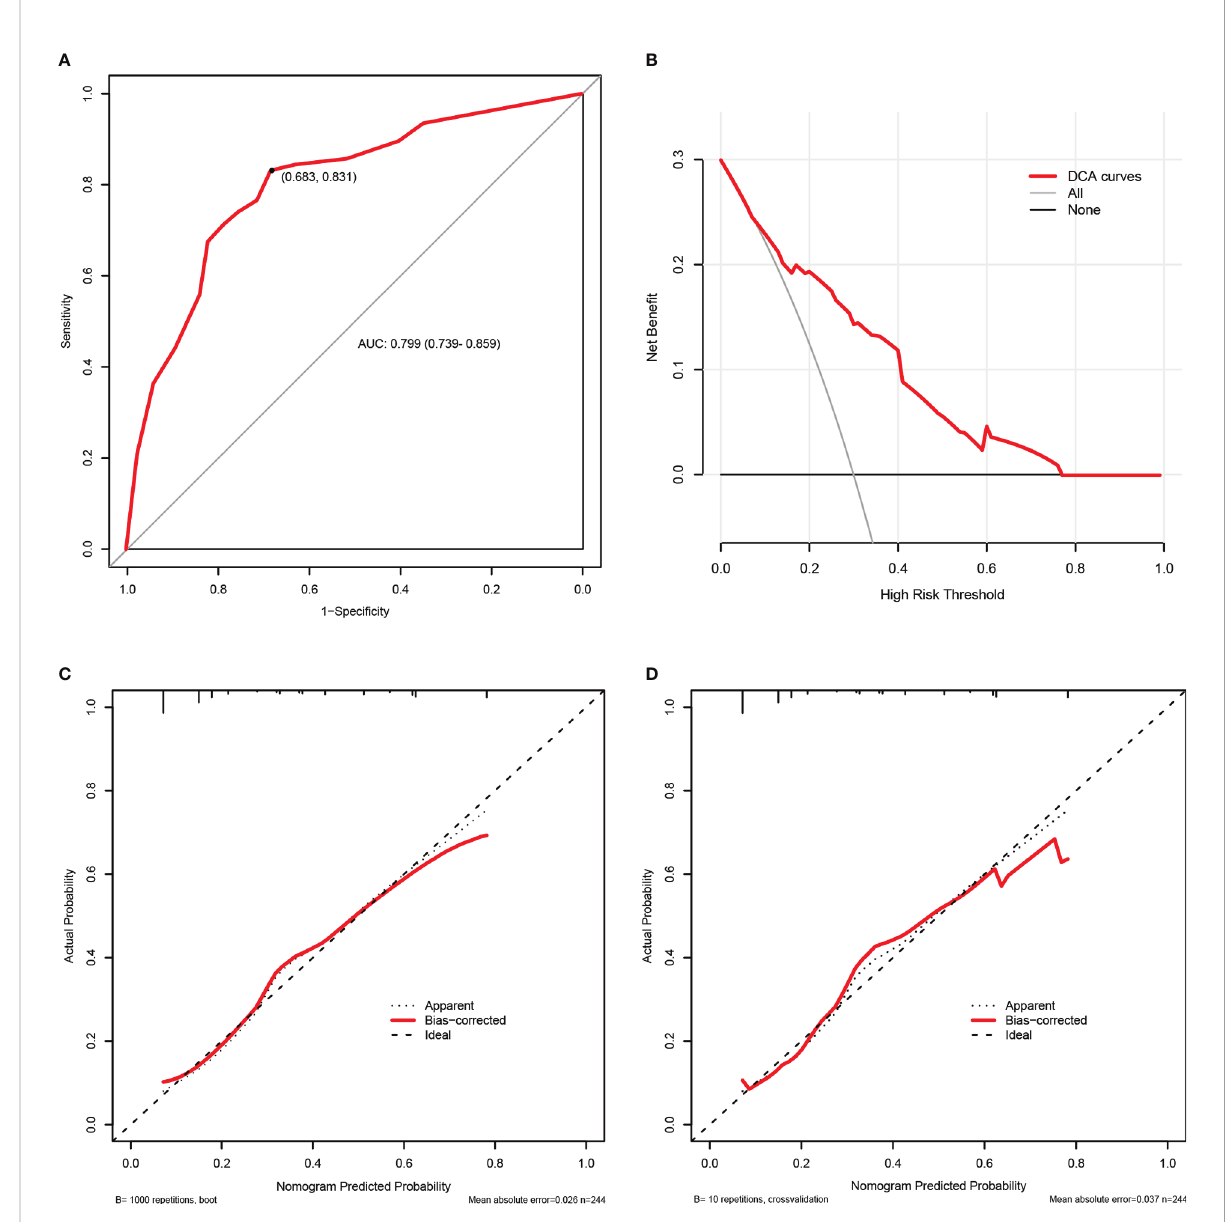
FIGURE 5 The internal validation of the carbapenem resistance nomogram according to bootstrap method and 10-fold cross validation. Receiver operating characteristic (ROC) curves of the carbapenem resistance nomogram (A) . Decision curve analysis (DCA) of the carbapenem resistance nomogram (B) . Calibration plots of the carbapenem resistance nomogram based on bootstrap method (C) and 10-fold cross validation (D)